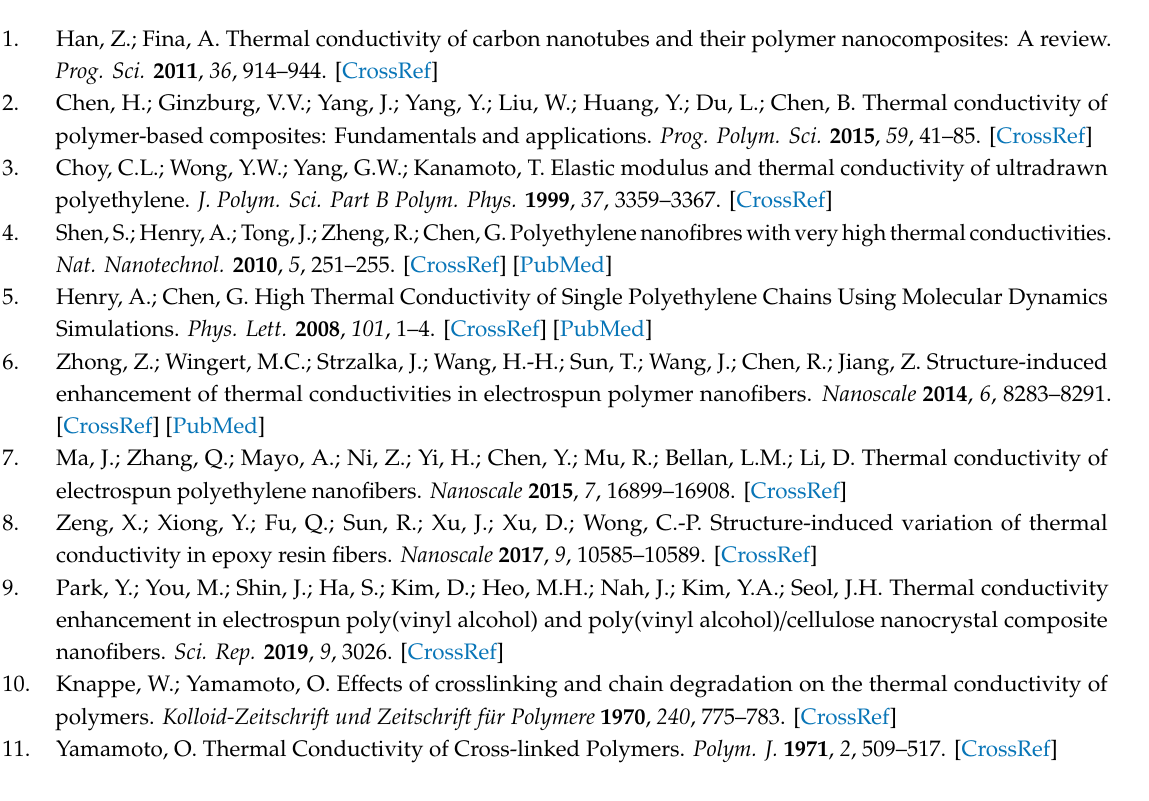
Figure S1: Diameter distributions of electrospun PAA NFs for various electrospinning voltages. Figure S2: SEM images taken before and after crosslinking of a PAA NF. Figure S3: Thermogravimetric curves for as-spun PAA and XLPAA NFs for various electrospinning voltages. Figure S4: Polarized Raman spectra of an as-spun PAA mat, which was electrospun at a voltage of 14 kV. Figure S5: Optical microscope images, which were taken while parallelly (a) and perpendicularly (b) polarized laser beams with respect to the fiber-long-axis were focused on an individual PAA NF. Figure S6: Polarized Raman spectra of as-spun PAA NFs and XLPAA NFs for various electrospinning voltages in a wavenumber range of 750 to 4000 cm − 1 . Figure S7: Parallel-polarized Raman spectra to incident light for an as-spun PAA NF and a XLPAA NF at 14 kV. Figure S8: Peak deconvolution of the C = O bands in the FTIR spectra of the as-spun PAA NFs. Figure S9: Peak deconvolution of the C = O bands ranging from 1500 to 1850 cm − 1 for investigating the anhydride structures. Figure S10: X-ray di ff raction analysis for the as-spun PAA and XLPAA NFs for various electrospinning voltages. Figure S11: Schematic of the measurement setup. Figure S12: Thermal conductivities of PAA NFs, which were electrospun at various voltages, with various diameters. Figure S13: Thermal conductivity of the as-spun PAA and XLPAA NFs as a function of diameter at room temperature. Table S1: Geometric change of a PAA NF before and after crosslinking. Table S2: Band assignment in Raman spectra of PAA. Table S3: Normalized percent areas of various –COOH groups normalized with those of the C = O bands for various electrospinning voltages. Table S4: Thermal conductivity of the as-spun PAA and XLPAA NFs for various electrospinning voltages and diameter at room